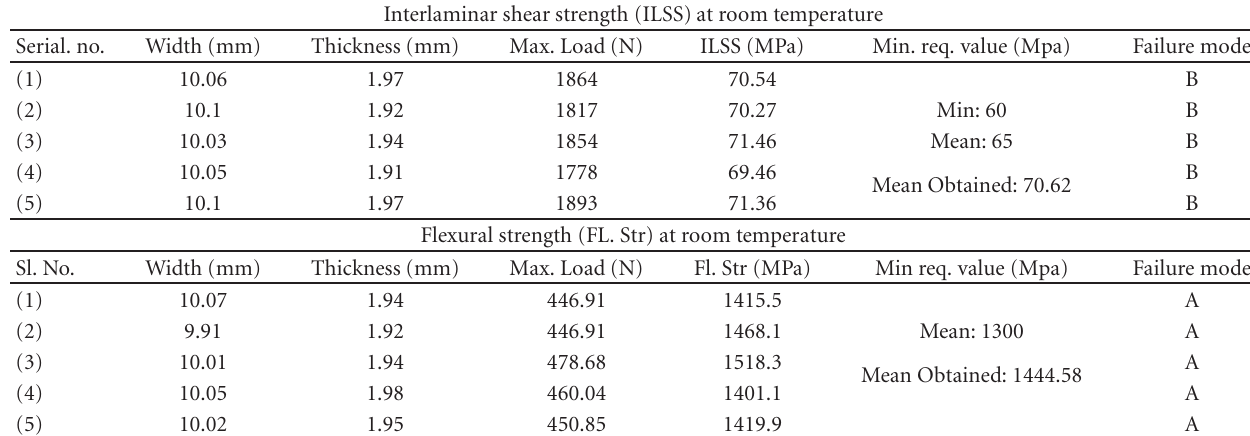
Table 1: Test report of a sample composite specimen. Material: Hexply G0827 BB1040 HP03 1F; Resin Epolam 2063. Interlaminar shear strength (ILSS) at room temperature Serial. no.